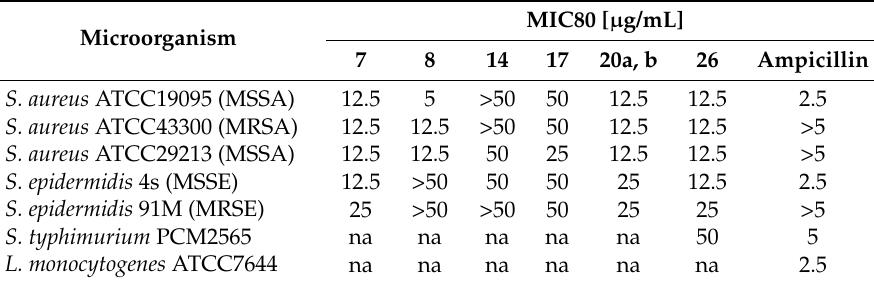
Table 2. Antibacterial activity of hops flavonoids and their derivatives.